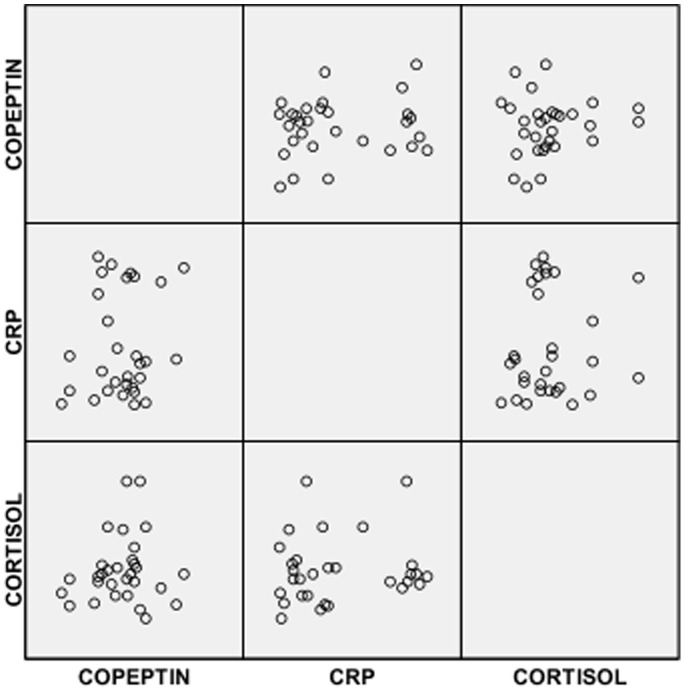
Scatter plots for CRP, copeptin and cortisol in SCA subjects in VOC.